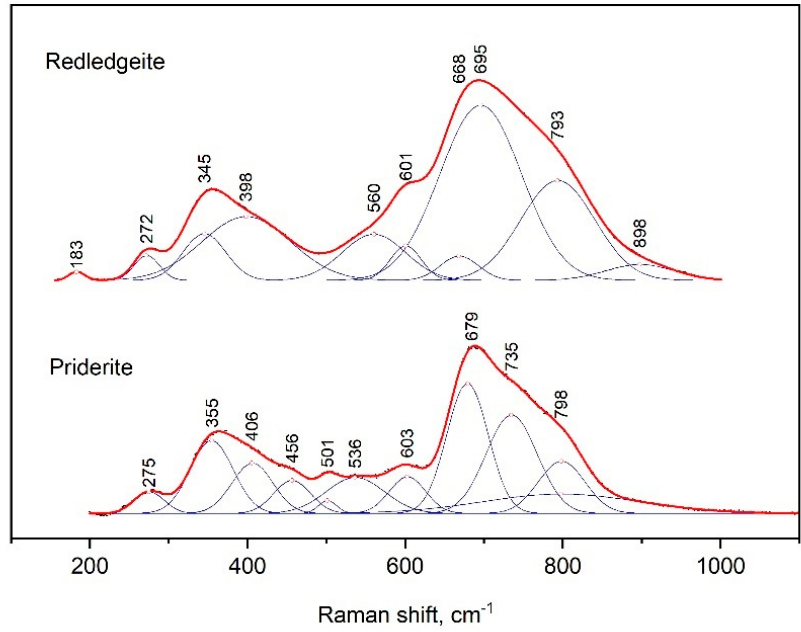
Figure 6. Raman spectrum of synthetic redledgeite and priderite, processed using the Fityk program.